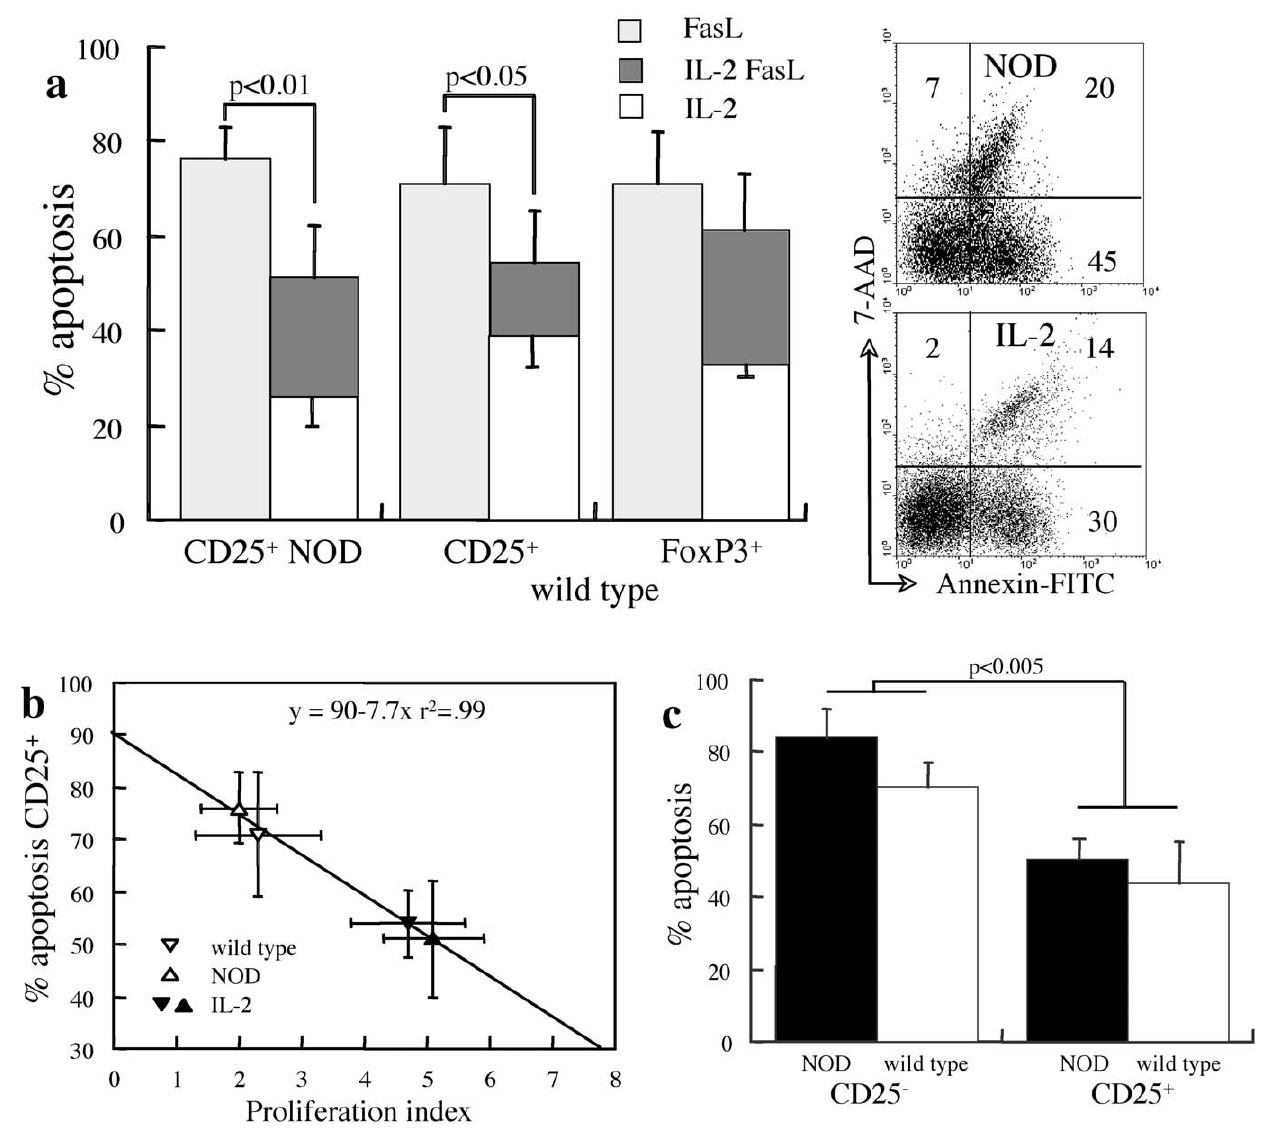
Figure 2. Impact of IL-2 on CD25 + T cell sensitivity to apoptosis and proliferation. A. Apoptosis of gated CD4 + CD25 + subsets in NOD (n=5) and wild type mice (n=7) and CD4 + FoxP3 + T cells in wild type mice (n=6) during 48 hours of incubation with supplementation of 2000 U/ml IL-2 (IL- 2) and with 50 m g/ml FasL (IL-2 FasL) as compared to apoptosis in response to FasL in control medium (FasL). Demonstrative measurements of apoptosis and death assessed by incorporation of Annexin-V and 7-AAD respectively. B. Fas-mediated apoptosis of CD4 + CD25 + T cells from NOD and wild type mice as a function of proliferation rates measured from CFSE dilution, with (n=4–5) and without (n=5–7) exogenous supplementation of IL-2 (n=4–5). C. Apoptosis of gated CD4 + CD25 2 and CD4 + CD25 + subsets induced by Fas cross-linking under mitogenic stimulation with ConA in NOD (n=4) and wild type mice (n=5).